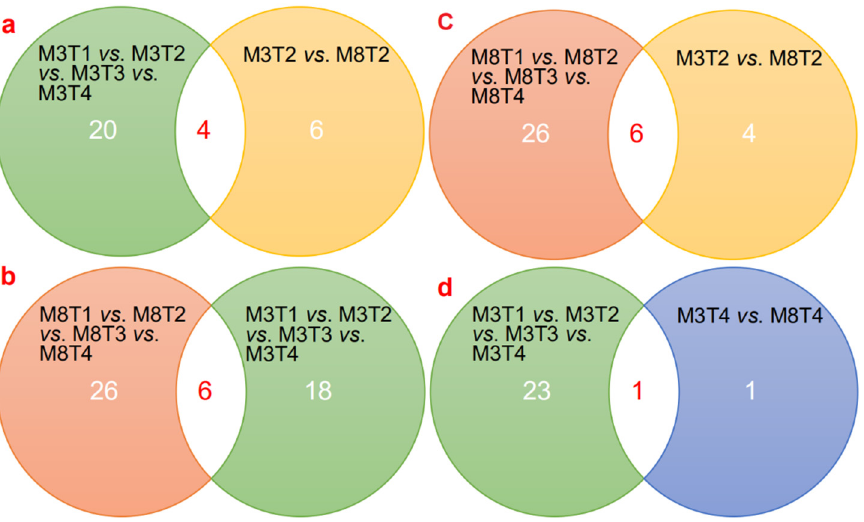
Figure 5. Venn diagrams of differentially expressed miRNAs between different comparison groups.